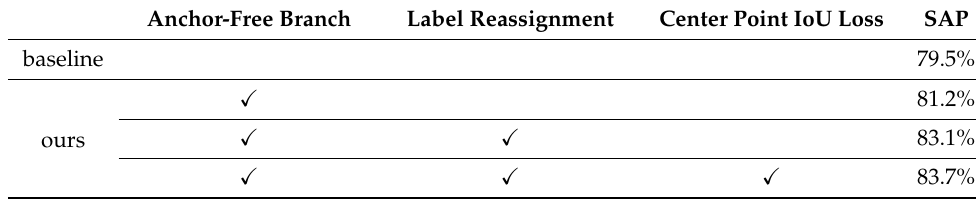
Table 2. Evaluation results of the hybrid anchor structure.